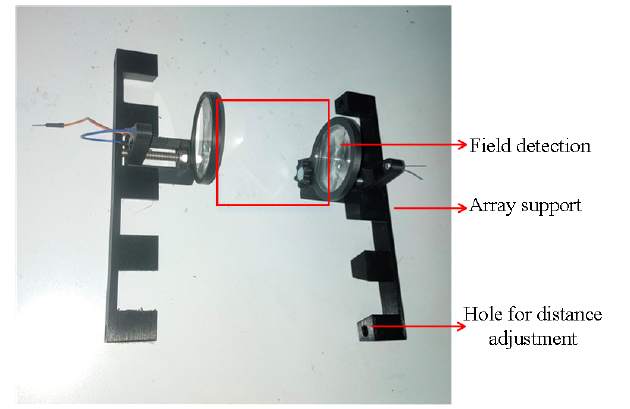
Figure 8. Experimental arrangement from 1 to 4 Fresnel